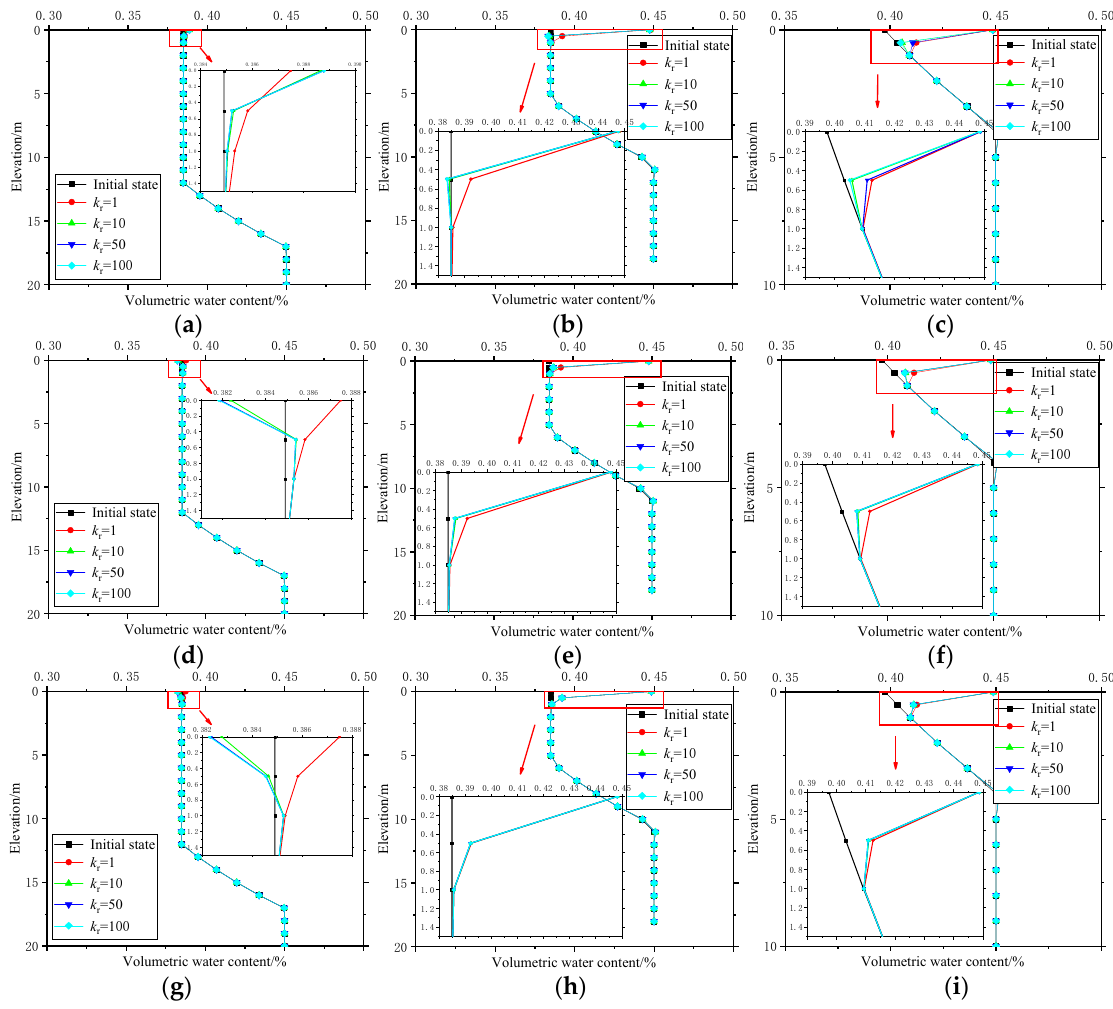
Figure 8. Variation of volumetric water content under different k r values for clayey soil. ( a ) Top of the slope with α = 0°. ( b ) Middle of the slope with α = 0°. ( c ) Toe of the slope with α = 0°. ( d ) Top of the slope with α = 45°. ( e ) Middle of the slope with α = 45°. ( f ) Toe of the slope with α = 45°. ( g ) Top of the slope with α = 90°. ( h ) Middle of the slope with α = 90°. ( i ) Toe of the slope with α = 90°.